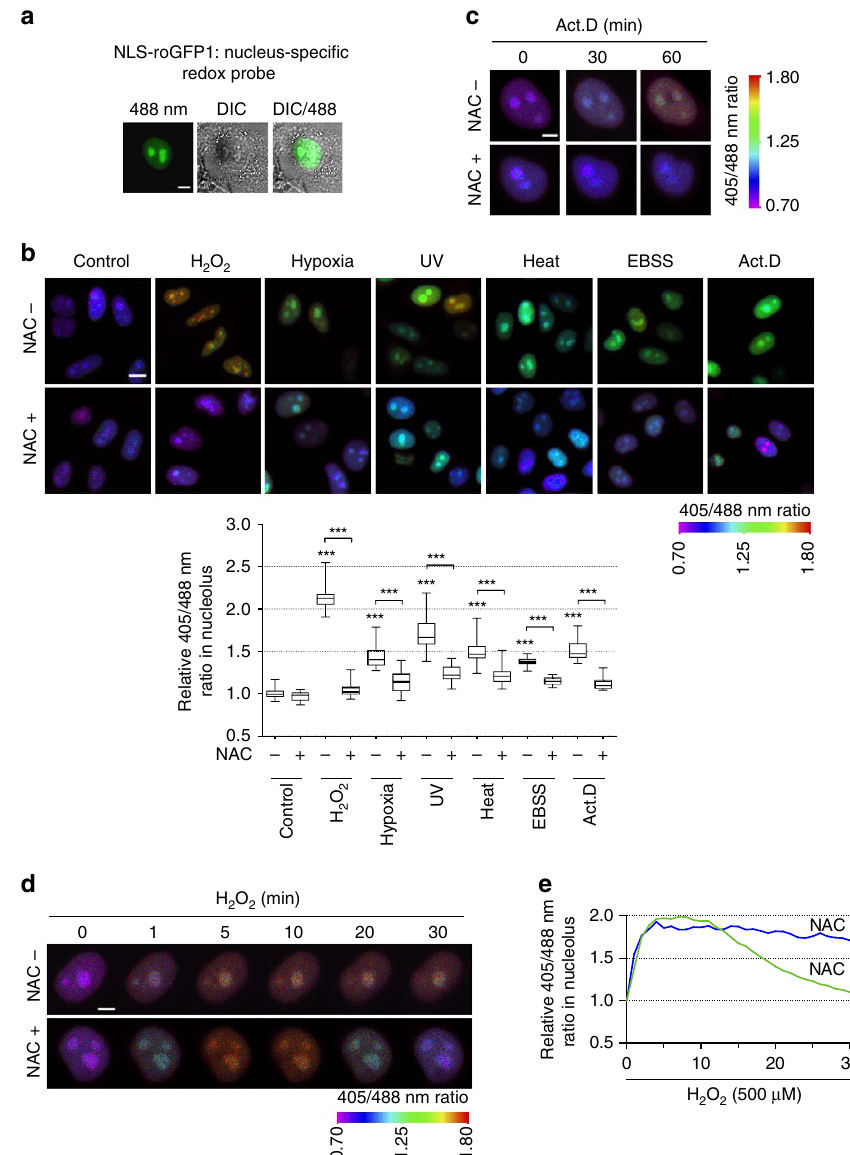
Figure 1 | Nucleolar oxidation is a general cellular stress response. ( a ) Nuclear localization of redox indicator NLS-roGFP1 in HeLa cells, indicated with DIC image. ( b ) Nucleolar redox changes indicated by NLS-roGFP1 in HeLa cells exposed to H 2 O 2 (500 m M, 30min), hypoxia (1% O 2 , 1h), ultraviolet irradiation (100Jm (cid:2) 2 ), heat shock (42 (cid:2) C, 30min), Earle’s balanced salt solution (EBSS; 6h) or Act.D (8nM, 1h) with or without ( ± ) 4h of the antioxidant NAC (5mM) pretreatment. Representative pseudocolourful images (upper, see Image processing and fluorescence signal quantifications for details) were shown and relative nucleolar ratio values were displayed (bottom). n ¼ 30 cells. Unpaired t -test, *** P o 0.001 with respect to treated versus untreated or (cid:2) NAC versus þ NAC cells and P o 0.001 with any of the NAC-treated cells versus control NAC-treated cells. ( c , d ) Nucleolar redox changes in HeLa cell exposed to Act.D (8nM, c ) or H 2 O 2 (500 m M, d ) ± NAC pretreatment, monitored by live-cell imaging. ( e ) Relative nucleolar ratio values changes per minute in d . Data were represented as mean ± s.e.m. Scale bars, 5 m m ( a , c , d ) and 10 m m ( b